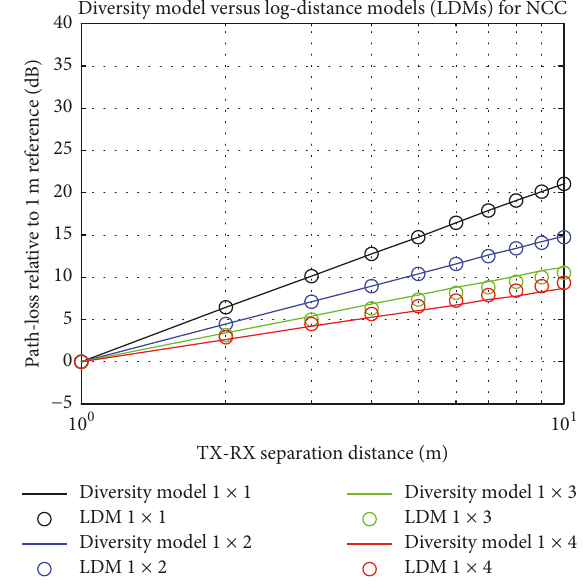
Figure 13: Path-loss for the proposed log-distance-based diversity model given by (5) for the NCC scheme when considering LOS scenario, with 𝑛 SISO = 2.105 and 𝐴 = 0.296